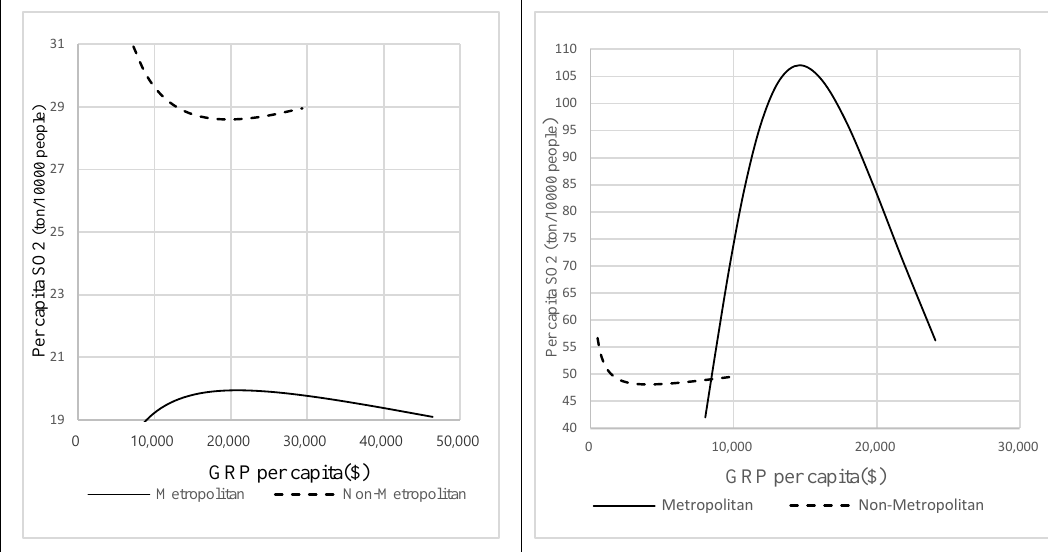
Figure 3. Pollution-Growth Patterns at Different City Scales in Two Countries.